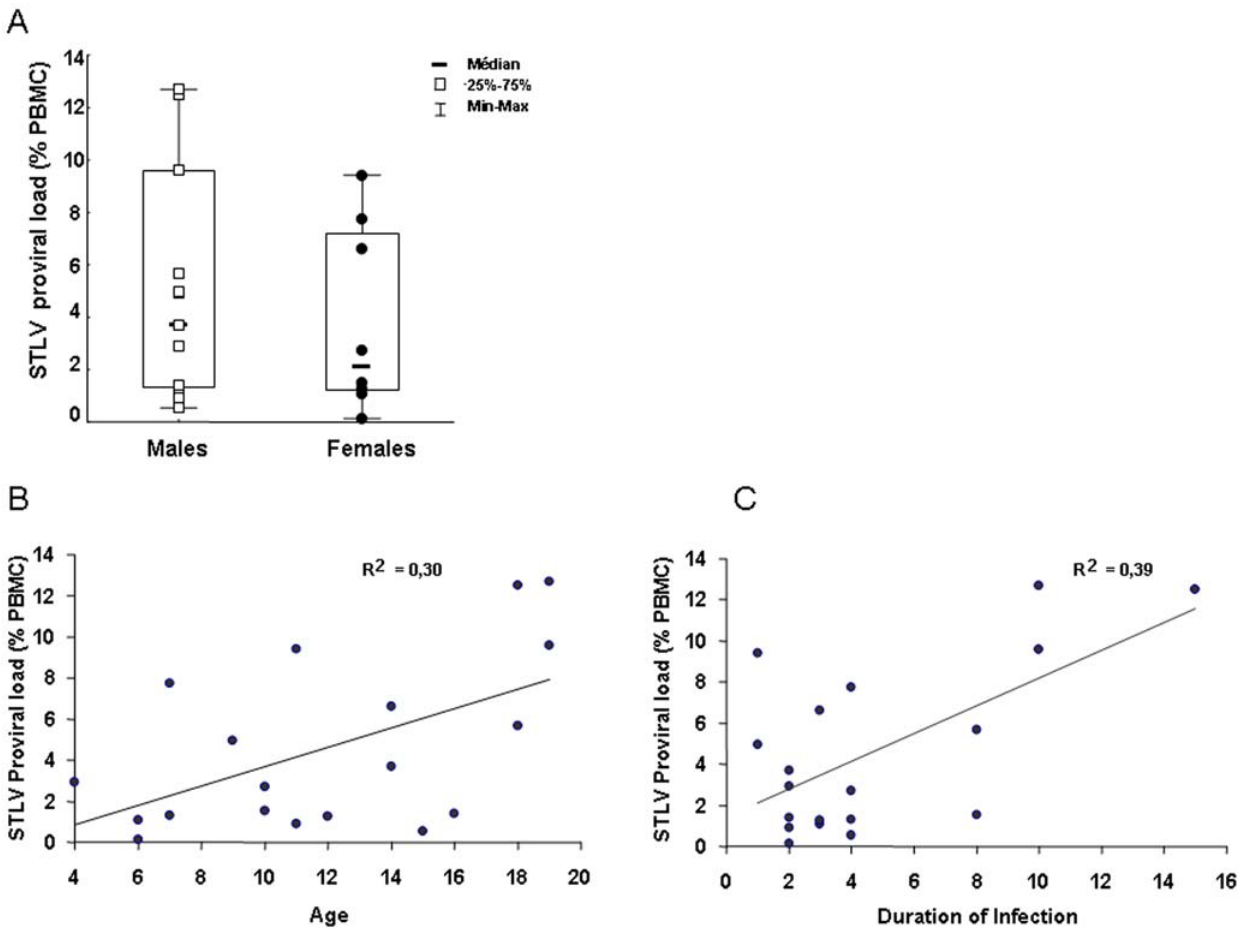
Figure 1. STLV-1 proviral load as detected by real-time PCR in 19 mandrills, expressed as copy numbers of provirus per 100 PBMC. (A) Proviral load distribution in male and female monkeys. (B) Correlation of STLV-1 proviral load with age of monkeys. (C) Correlation of STLV-1 proviral load with duration of STLV-1 infection.